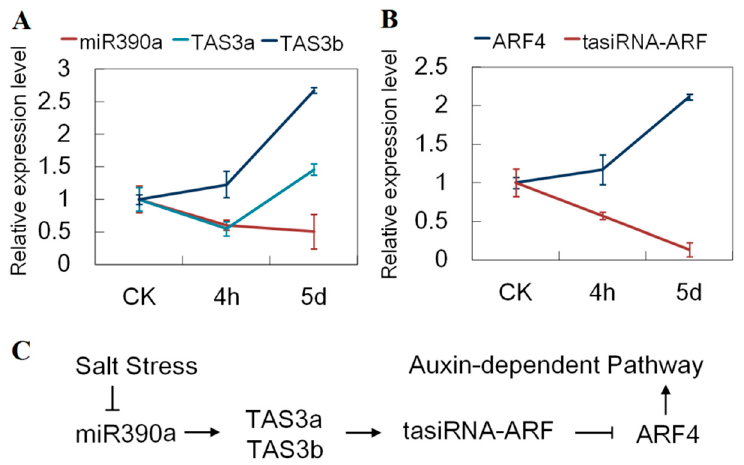
Figure 9. miR390/tasiRNA-ARF/ARF4 pathway analysis. Error bars represent standard error of the mean. ( A ) Relative expression levels of miR390 and TAS3 under salt stress; ( B ) Relative expression levels of tasiRNA-ARFs and ARF4 under salt stress; ( C ) A model for the role of the miR390/tasiRNA-ARF/ARF4 module under salt stress.